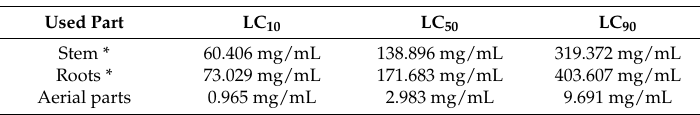
Table 3. Lethal concentrations (LC 10 , LC 50 and LC 90 ) of Helicteres velutina CEE against Aedes aegypti larvae (24 h of exposure)